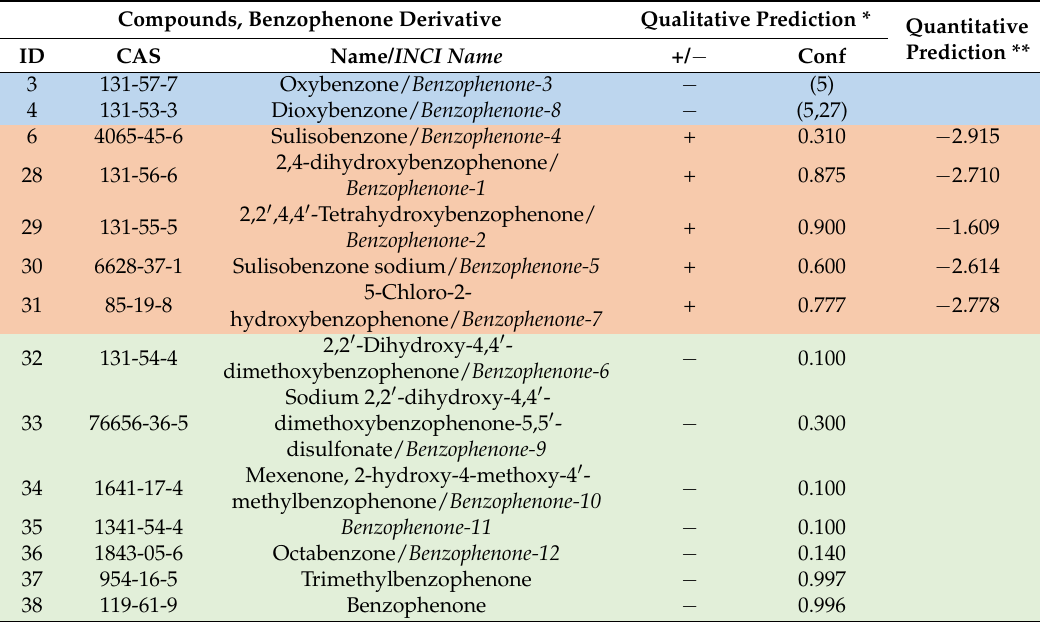
Table 2. Predicted Estrogenic activity of benzophenone